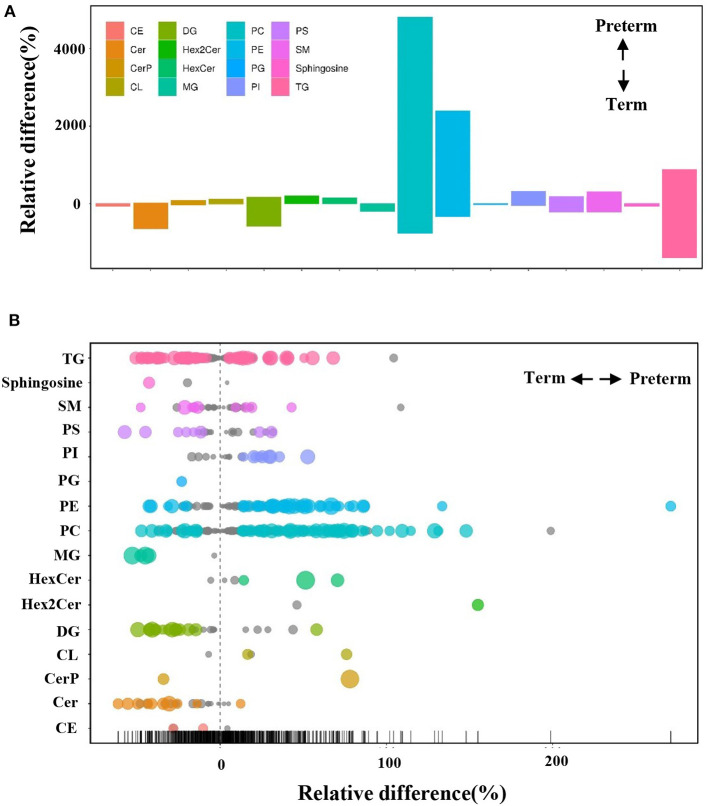
Differences in the relative percentage of significantly different lipid species between preterm and term human milk. (A) The bar plot shows the relative difference in the detected significantly different lipids. Each column represents a subclass of lipids. The y axis represents the relative difference of various lipids. A positive relative difference indicates that the content of this kind of substance was higher in the preterm group. A negative relative difference indicates that the content of this kind of substance was higher in the term group. The values corresponding to the top and bottom margins of the column represent the relative difference. (B) A bubble plot shows the relative differences in the detected lipids. Each point represents a lipid. The size of the point represents the P-value. Larger points represent smaller P-values. Colored points indicate that the P < 0.05.